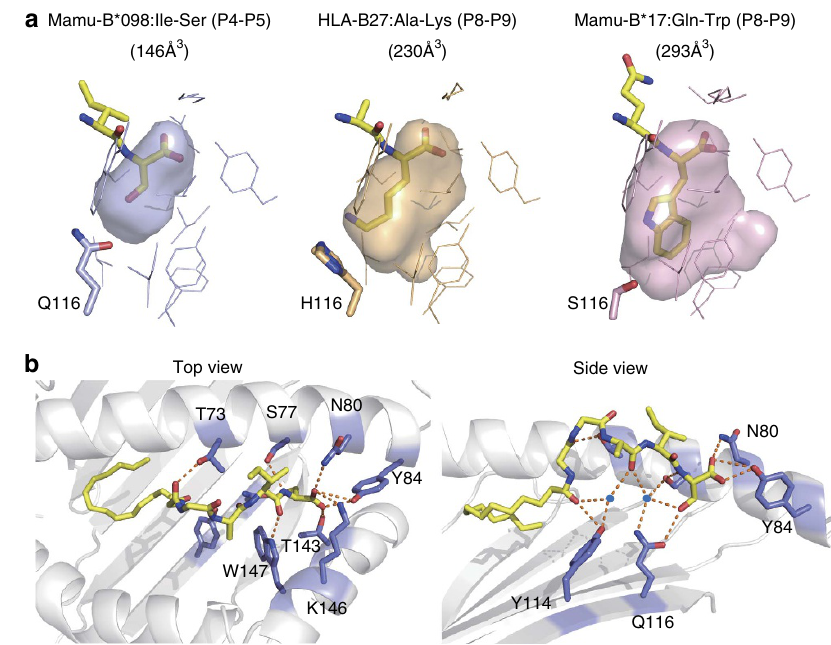
Figure 4 | Interactions with the peptide chain of the lipopeptide. ( a ) F pockets of Mamu-B*098 (left, blue), HLA-B27 (middle, light orange) and Mamu-B*17 (right, pink) are shown as a semi-transparent groove and side chains (lines) with an emphasis on the key side chains at position 116. Two C-terminal amino acid residues of the ligands anchored in each F pocket are displayed as yellow sticks. ( b ) A hydrogen bond network was established between Mamu-B*098 and C14nef5. The top (left) and side (right) views of the Mamu-B*098:C14nef5 complex are displayed with hydrogen bonds (orange dashed lines). Water molecules are shown with blue